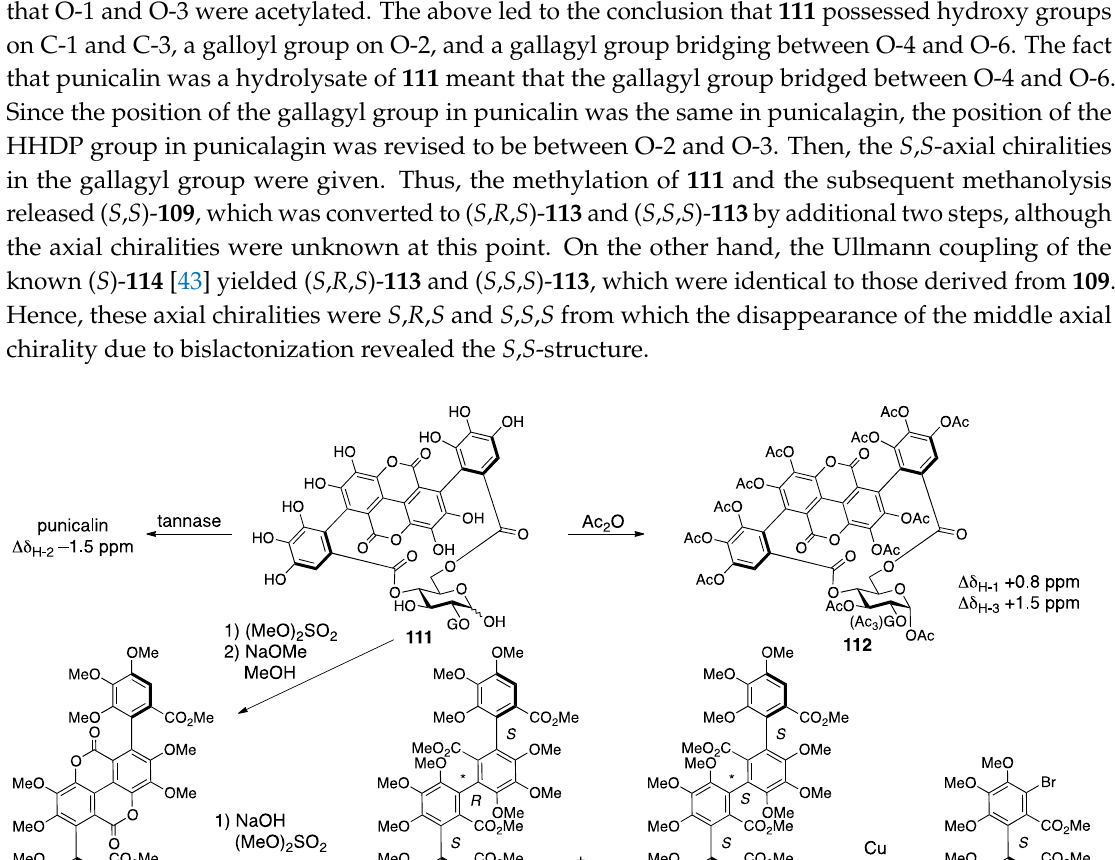
Figure 41. The degradation used for the structural determination of the first structures of punicalin and punicalagin.